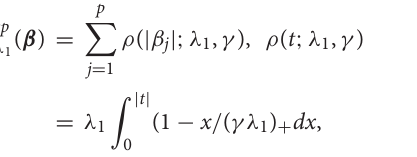
2. (A) The elements of =